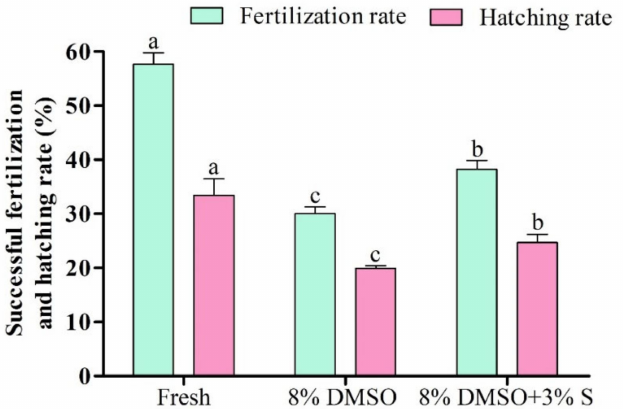
Figure 12. Fertilization and hatching rate of saccharide supplemented cryopreserved sperm of Pacific abalone. DMSO; dimethyl sulfoxide, and S; sucrose. Significantly different levels ( p < 0.05) are denoted by different